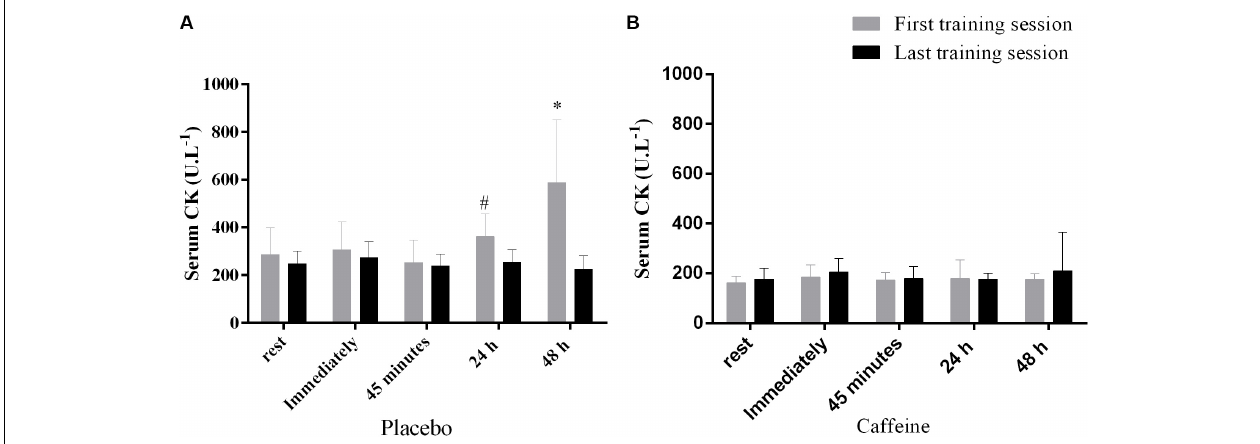
FIGURE 3 | Serum creatine kinase after the first and last training session in the placebo (A) and caffeine (B) group. # Significantly higher than at 45 min in the session 1, p < 0.05. ∗ Significantly higher than at rest, immediately, 45 min and 24 h in the first training session, p < 0.05. Data are mean and standard error of mean ( n = 6 and 7 in PLA and CAF groups,